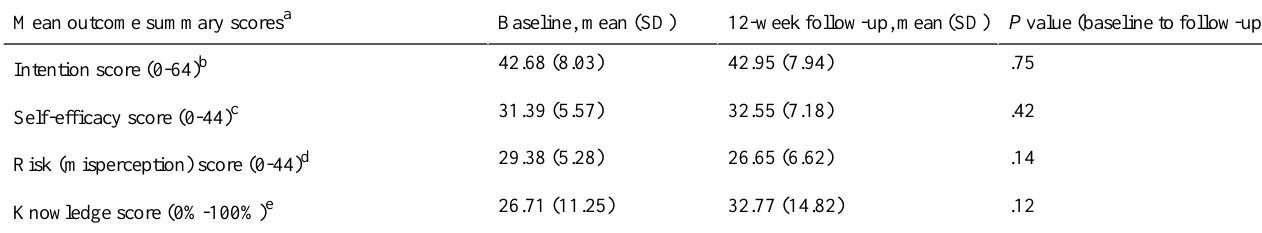
Table 2. Participant summary scores for key intervention targets before video game intervention and at 12-week follow-up.